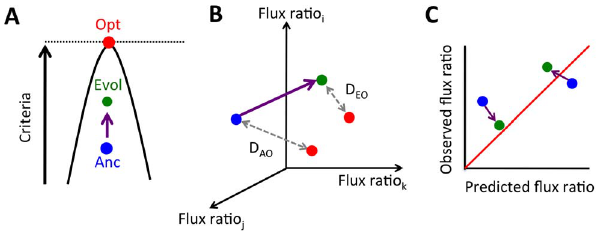
Figure 1. Evolution of metabolic fluxes and measures of optimality and predictability. We consider three ways to analyze changes in metabolism that relate an ancestor (Anc, blue) to an evolved isolate (E i , green) in regard to an FBA-predicted optimum (Opt, red). A) Evolution of metabolic fluxes can be evaluated from the perspective of changes in proximity to the theoretical maximum for a given optimality criterion ( D % Optimality). B) A vector of flux ratios defines a position in multi-dimensional flux space. One can then consider the relative Euclidian distance of a given evolved population in this space from its optimum (D EO ) compared to that of an ancestor from its optimum (D AO ; plotted as log(D EO /D AO )). C) At the most detailed level, one can compare the FBA-predicted value for a given flux ratio versus that observed via 13 C labeling.